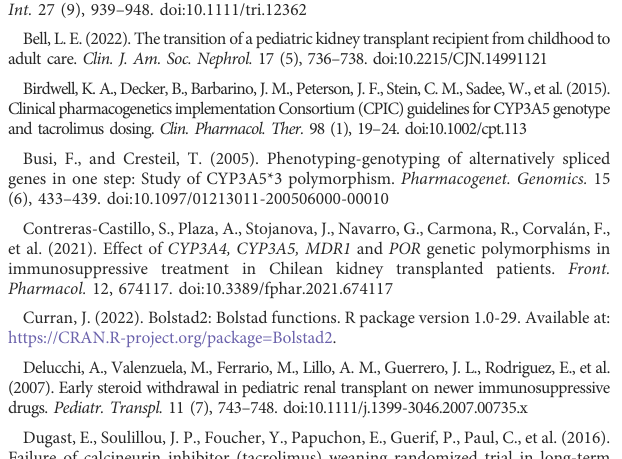
SUPPLEMENTARY FIGURE S1 Spider chart to visualize fi ve indices of model performance ( r 2 , adjusted r 2 , weightBIC(wBIC),weightAIC(wAIC)andMAPE -1 (reciprocalvalueofMAPE) for the four LSS models and allow comparison of indices across models 7 (red line), 12 (green line), 13 (yellow line) and 15 (purple line). The primary descriptors (speci fi c TAC time-points for each AUC model) are shown. SUPPLEMENTARY FIGURE S2 Relationship between the TAC observed trapezoidal and predicted AUC (0-24) according to the equation LSS-AUC (0 – 24) =26.0+11.27*C 0 +1.97*C 1 +8.13*C 4 , with theexpressor(pinkdots)orthenon-expressor(turquoisedots)CYP3A5phenotype. The solid black line is the regression line and the gray shaded area represents 95% con fi dence interval for the regression line ( r 2